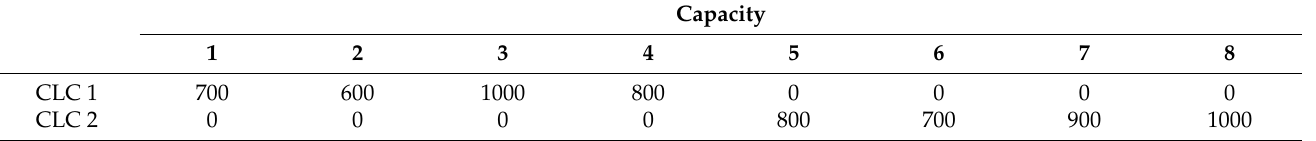
Table 5. Container